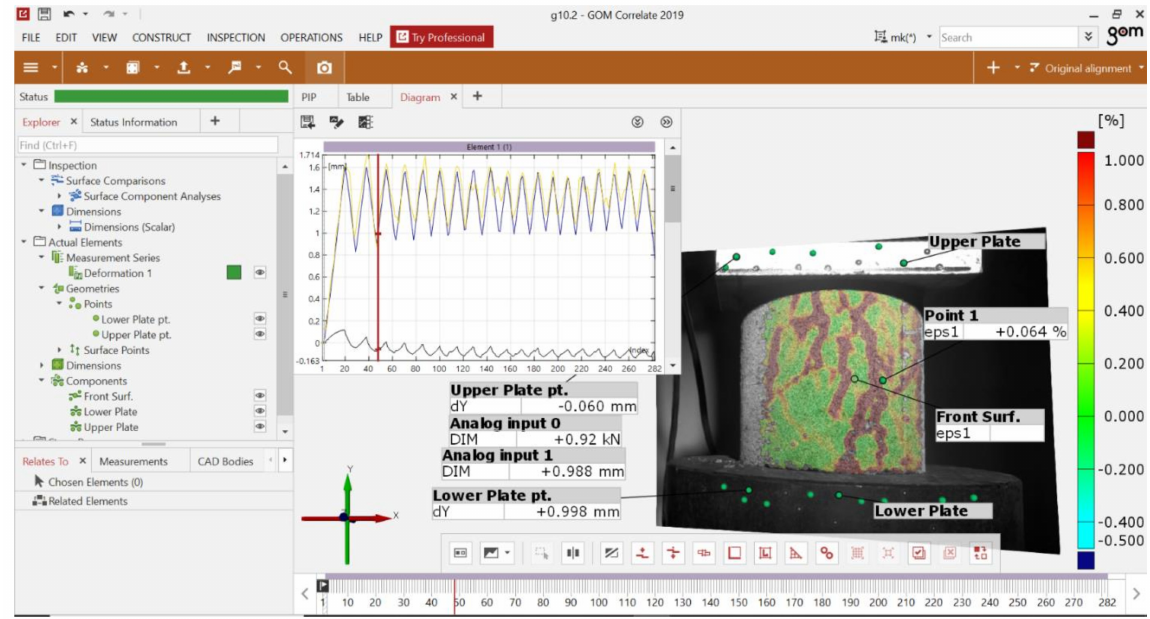
Figure 6. View of ARAMIS 3D measurement system